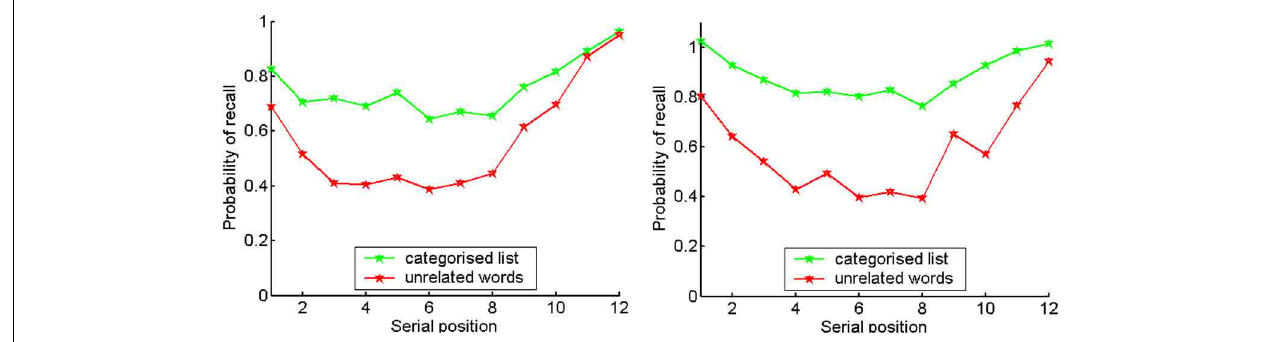
FIGURE 10 | Probabilities of recall for same-category (green) and unrelated lists (red). Right: Experiment 2a, left: Experiment